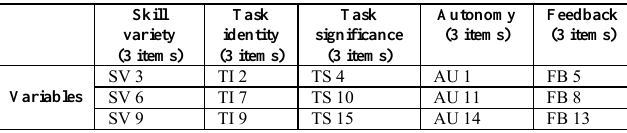
Table 2: Items per factor for the revised